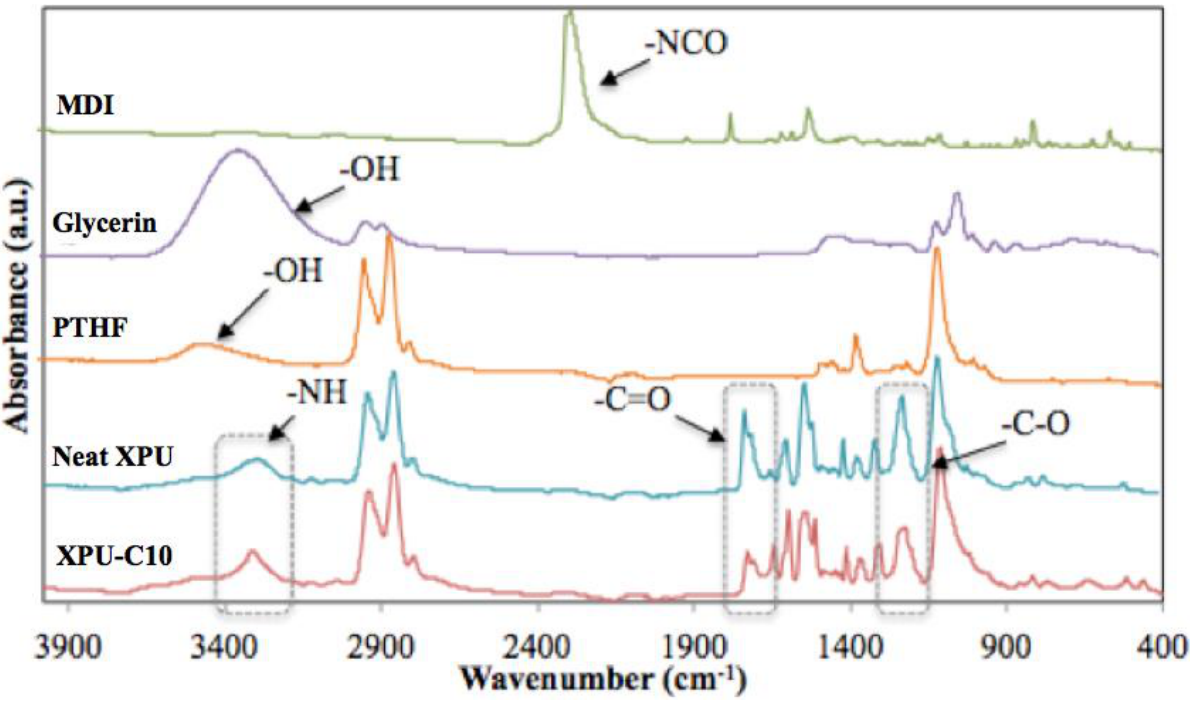
Figure 1. FTIR spectra of the monomers (MDI, glycerin, and PTHF), neat XPU and XPU-C10.